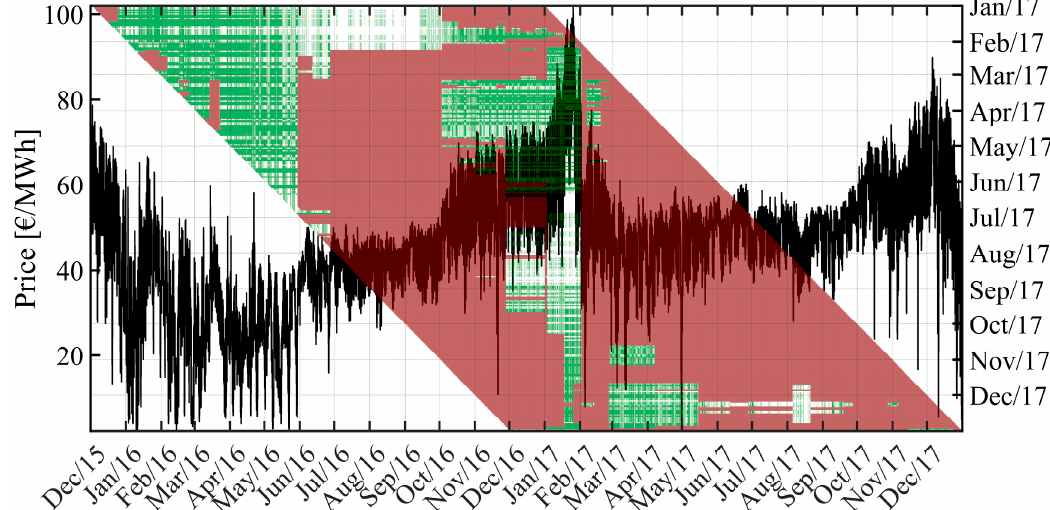
Figure 4. Addition of an hourly clustering method to the period selection methodology.